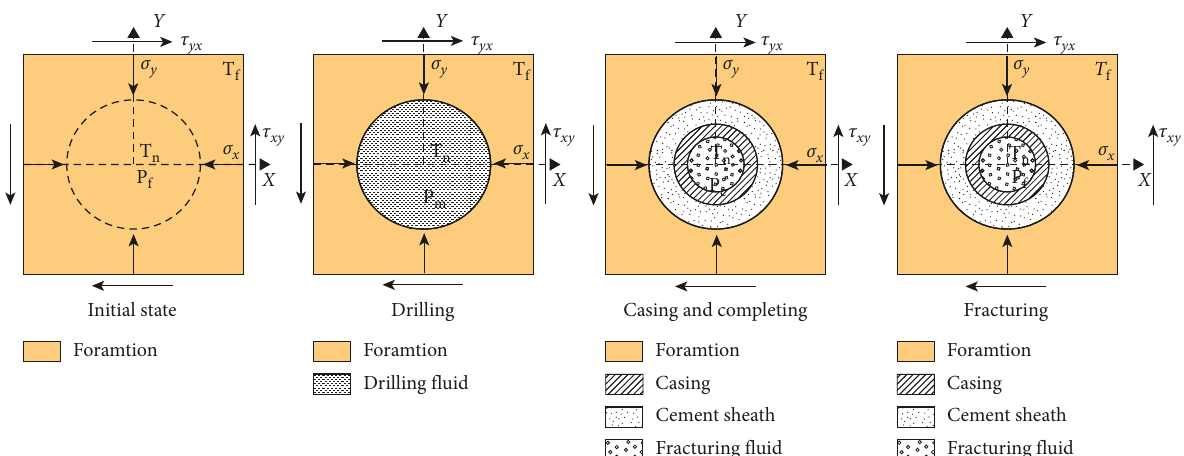
Figure 1: Loading process of the existing method. Outer boundary temperature, T σ y ; shear stress τ xy